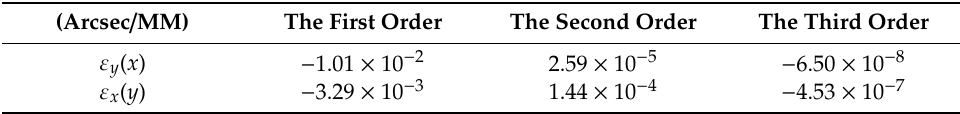
Table 2. Coe ffi cients of ε y ( x ) and ε x ( y ).